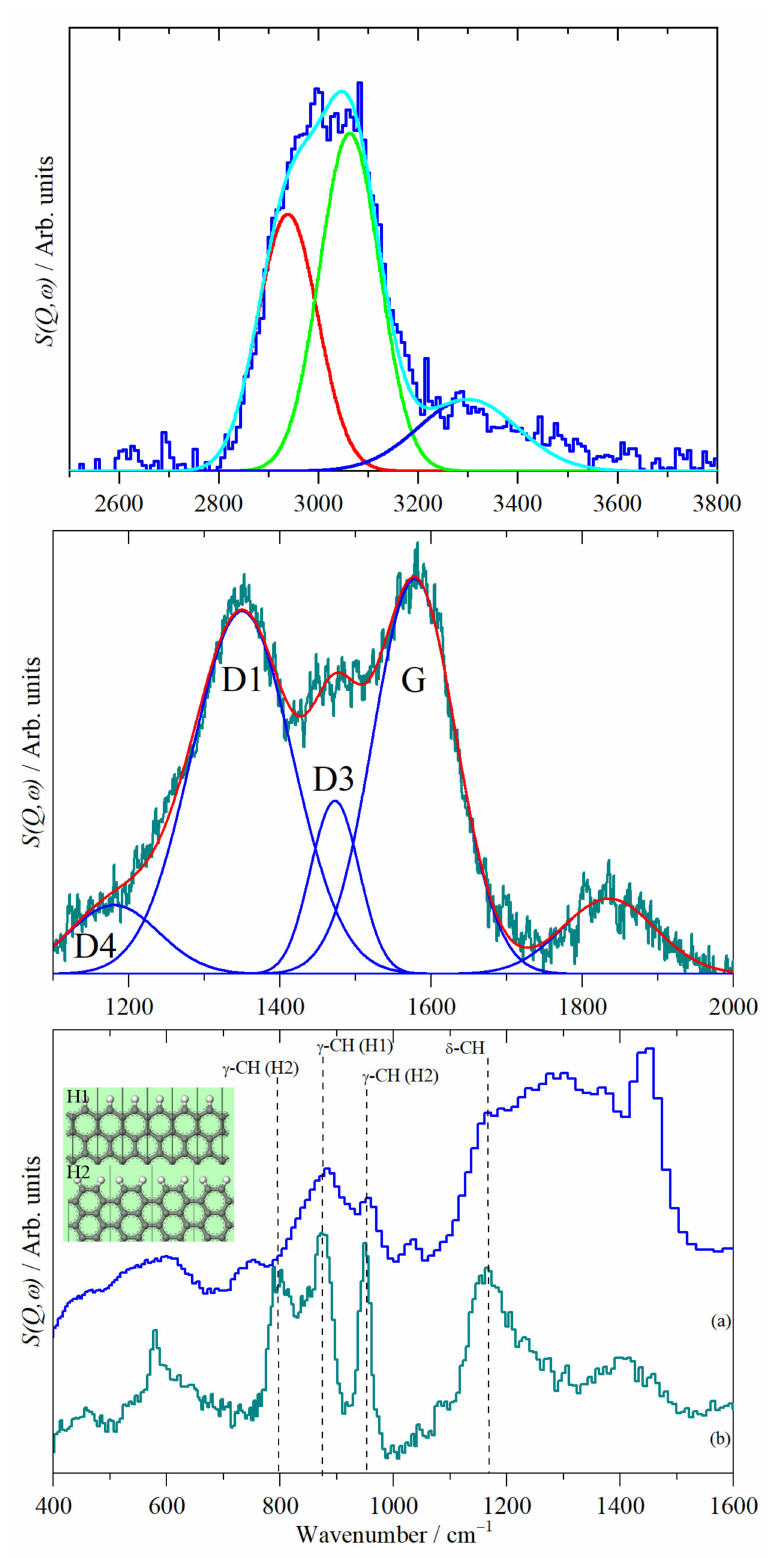
Figure 6. Top: Curve fit to the MAPS INS spectrum in the C–H and O–H stretch region. Middle: Curve fit to the Raman spectrum in the range of the G and D bands. Bottom: comparison of the TOSCA INS spectrum of biochar ( a ) and that of glassy carbon ( b ) [50] in the region of the aromatic C– H-bending modes. The inset shows the definition of H1 (an isolated C–H bond) and H2 (two adjacent C–H bonds)